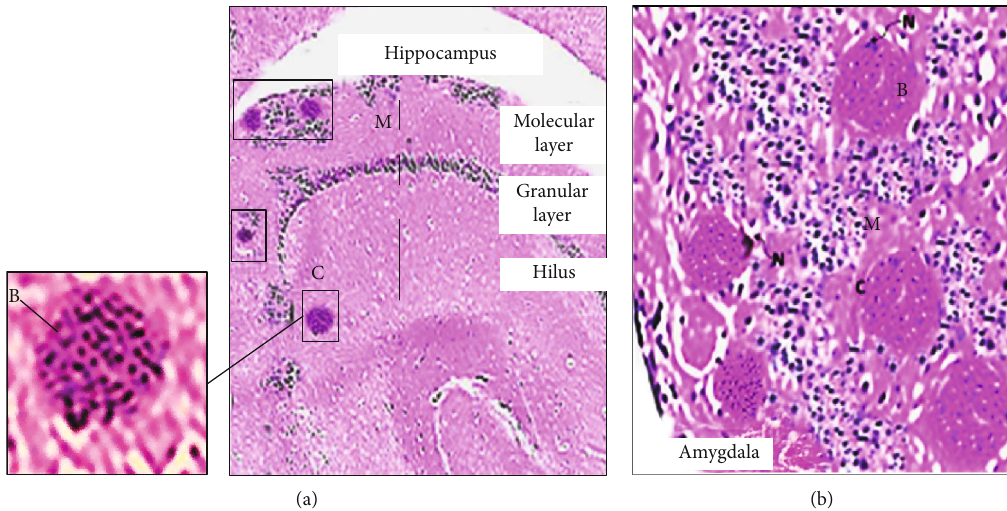
Figure 1: Hematoxylin and eosin stain where the plate re fl ects the cerebral lesions of T. gondii in the chronically infected Swiss albino mice. (a) Hippocampus with scattered variable-sized bradyzoites encased in cysts (C) in the hilus layer and the molecular layer (M) of the ventral hippocampus (40x). (b) Amygdala lodged with hundreds of bradyzoites (B) in cysts (note the basophilic dot-like terminal nuclei of the parasite) encased in the intracellular cysts (C) (note the lateral nucleus of the host cell (N)) surrounded by mononuclear chronic in fl ammatory in fi ltrates (M)